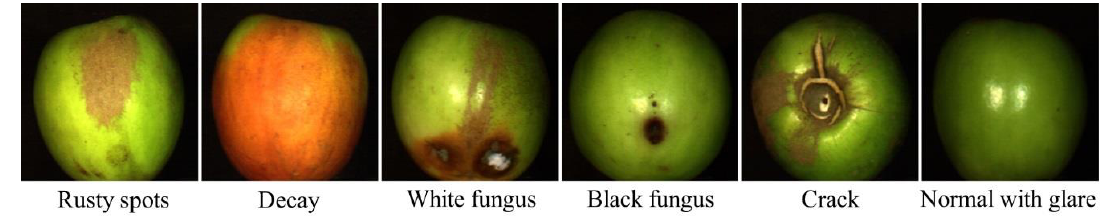
Figure 1. Common skin defects and glare on normal surface of Kaohsiung No.11 jujube.